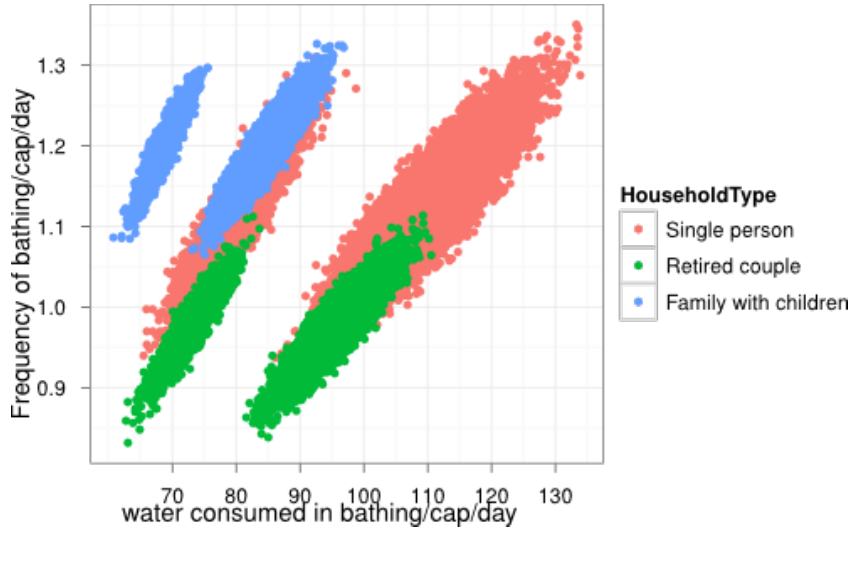
Figure 9. A scatter plot of agent bathing frequency (shower or bath) and water consumption in L/agent/day in these activities. The agents of different household types are distinguished with colors. Each single point represents the outcome of one model run. There are 21,000 observations for both family and couple and 64,800 observations for